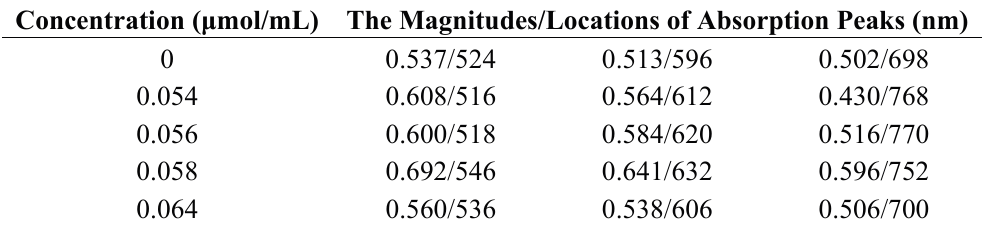
Table 1. The magnitudes and locations of absorption peaks under different concentrations of RhB.